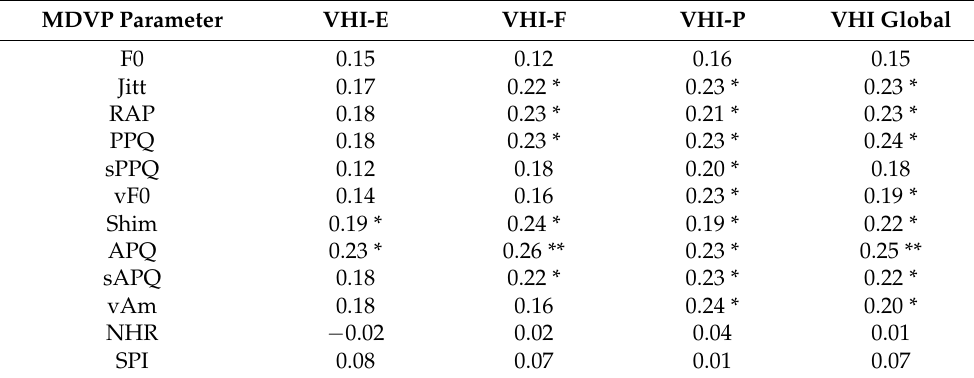
Table 2. Rho-Spearman correlations between VHI-POL scores and MDVP parameters.